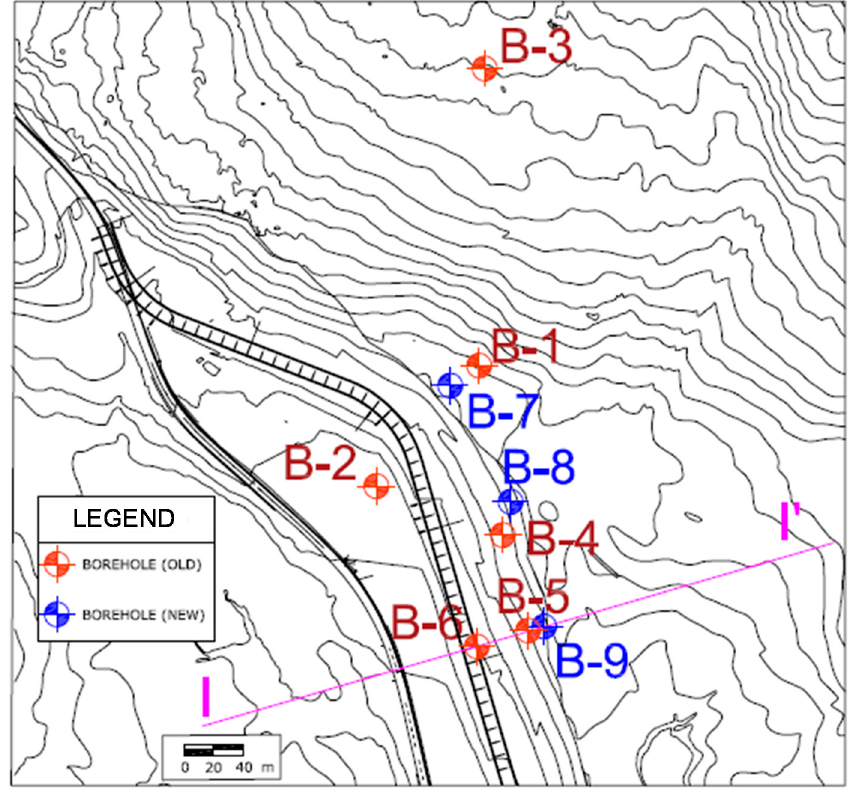
Figure 2. Location of the boreholes performed in the previous study [15] (“old” boreholes, conducted in 2005, reprinted with permission from ref. [15], Copyright Year 2005, Copyright Owner’s F.J. Torrijo) and the new geotechnical investigation (“new” boreholes, conducted in 2016); profile I-I ′ relates to Figure 5.